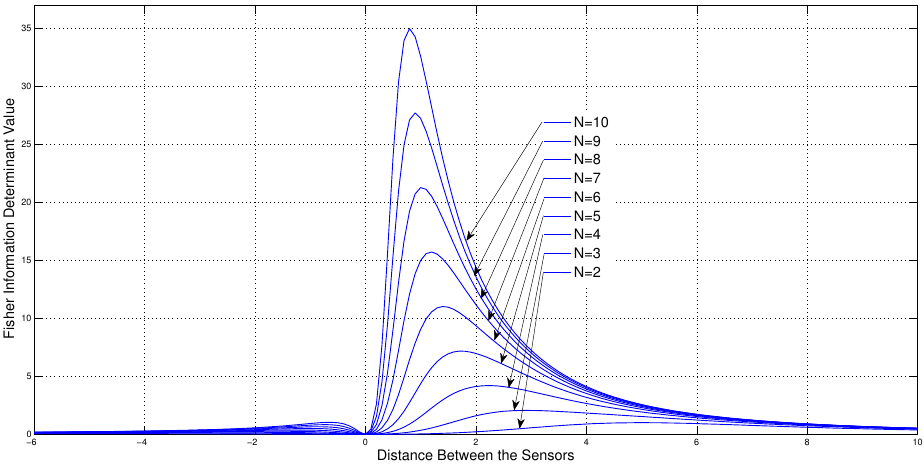
Figure 4. Variation of Fisher information determinant value with the distance between two adjacent sensors of ULA for different number of AoA sensors (One sensor